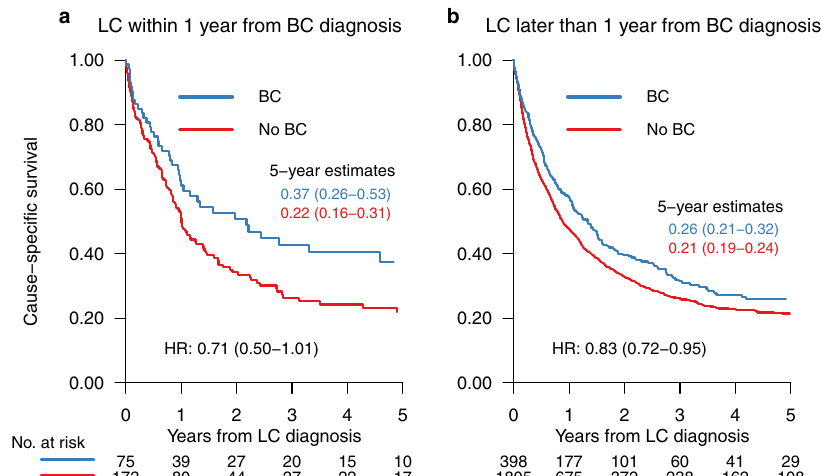
Fig. 2 Lung cancer-speci fi c survival. Lung cancer-speci fi c survival within ( a ) and after ( b ) the fi rst year from study onset, for women with breast cancer (BC) and women without BC diagnosis. Lung cancer (LC) and number